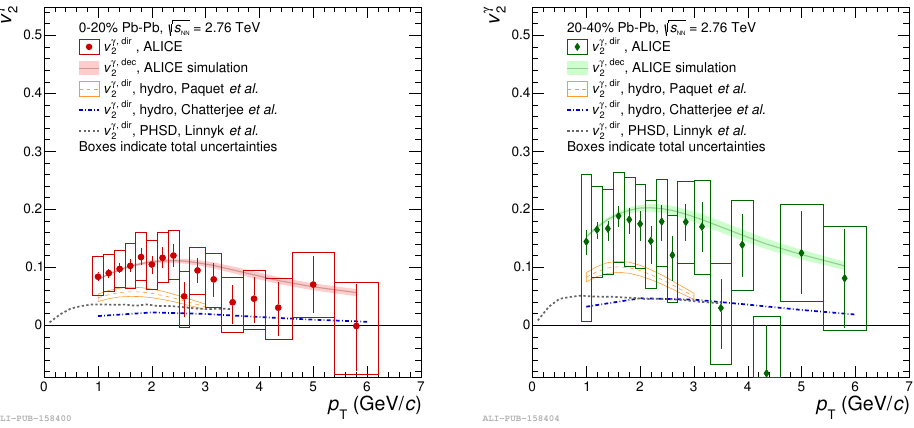
Figure 4. Direct photon elliptic flow measured in two centrality classes, 0-20% (left plot) and 20-40% (right plot) in Pb–Pb collision at √ s NN = 2 . 76 TeV. For comparison the decay photon elliptic flow and predictions of hydrodynamic and transport models are